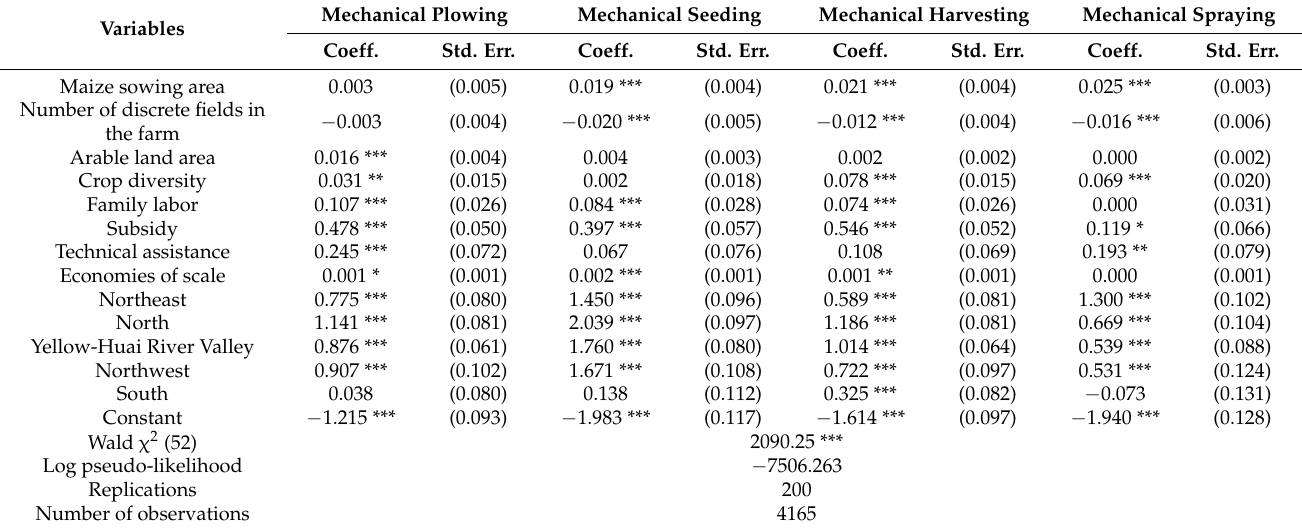
Table 5. Results of multivariate probit models of adoption of four machinery technologies.